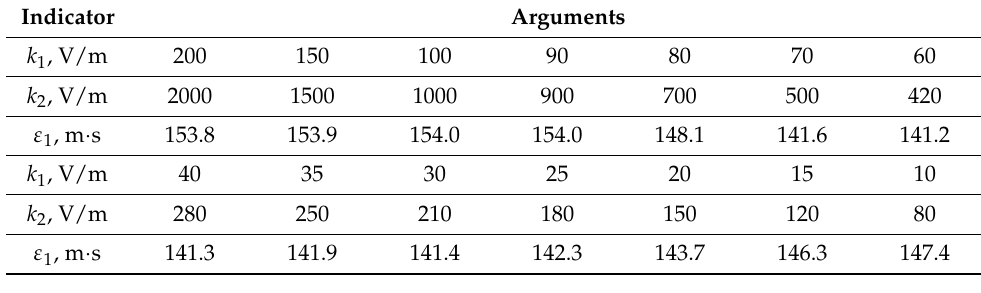
Table 2. The values of the coefficients of the PD controller.